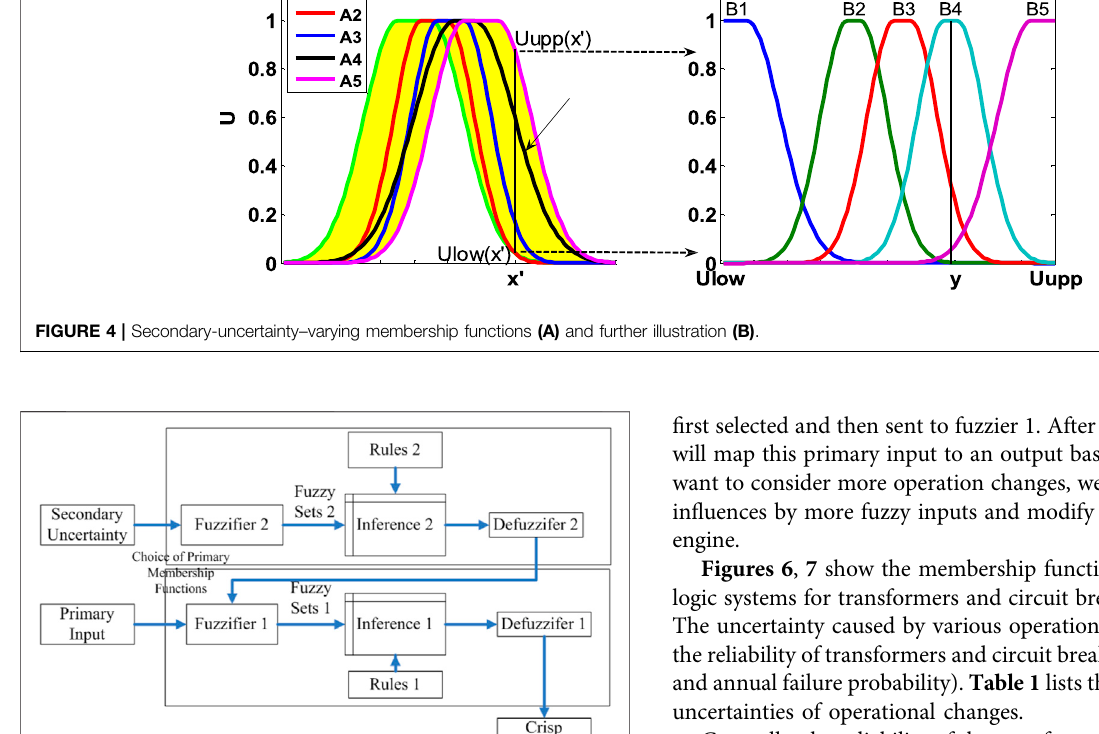
Figure 5 is a schematic diagram of the type 2 fuzzy logic system of the second uncertainty change. As shown in Figure 5 ,